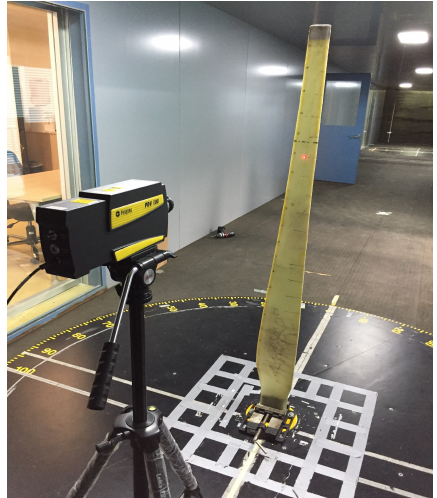
Figure 3. Blade set-up for modal testing based on impact hammer excitation.